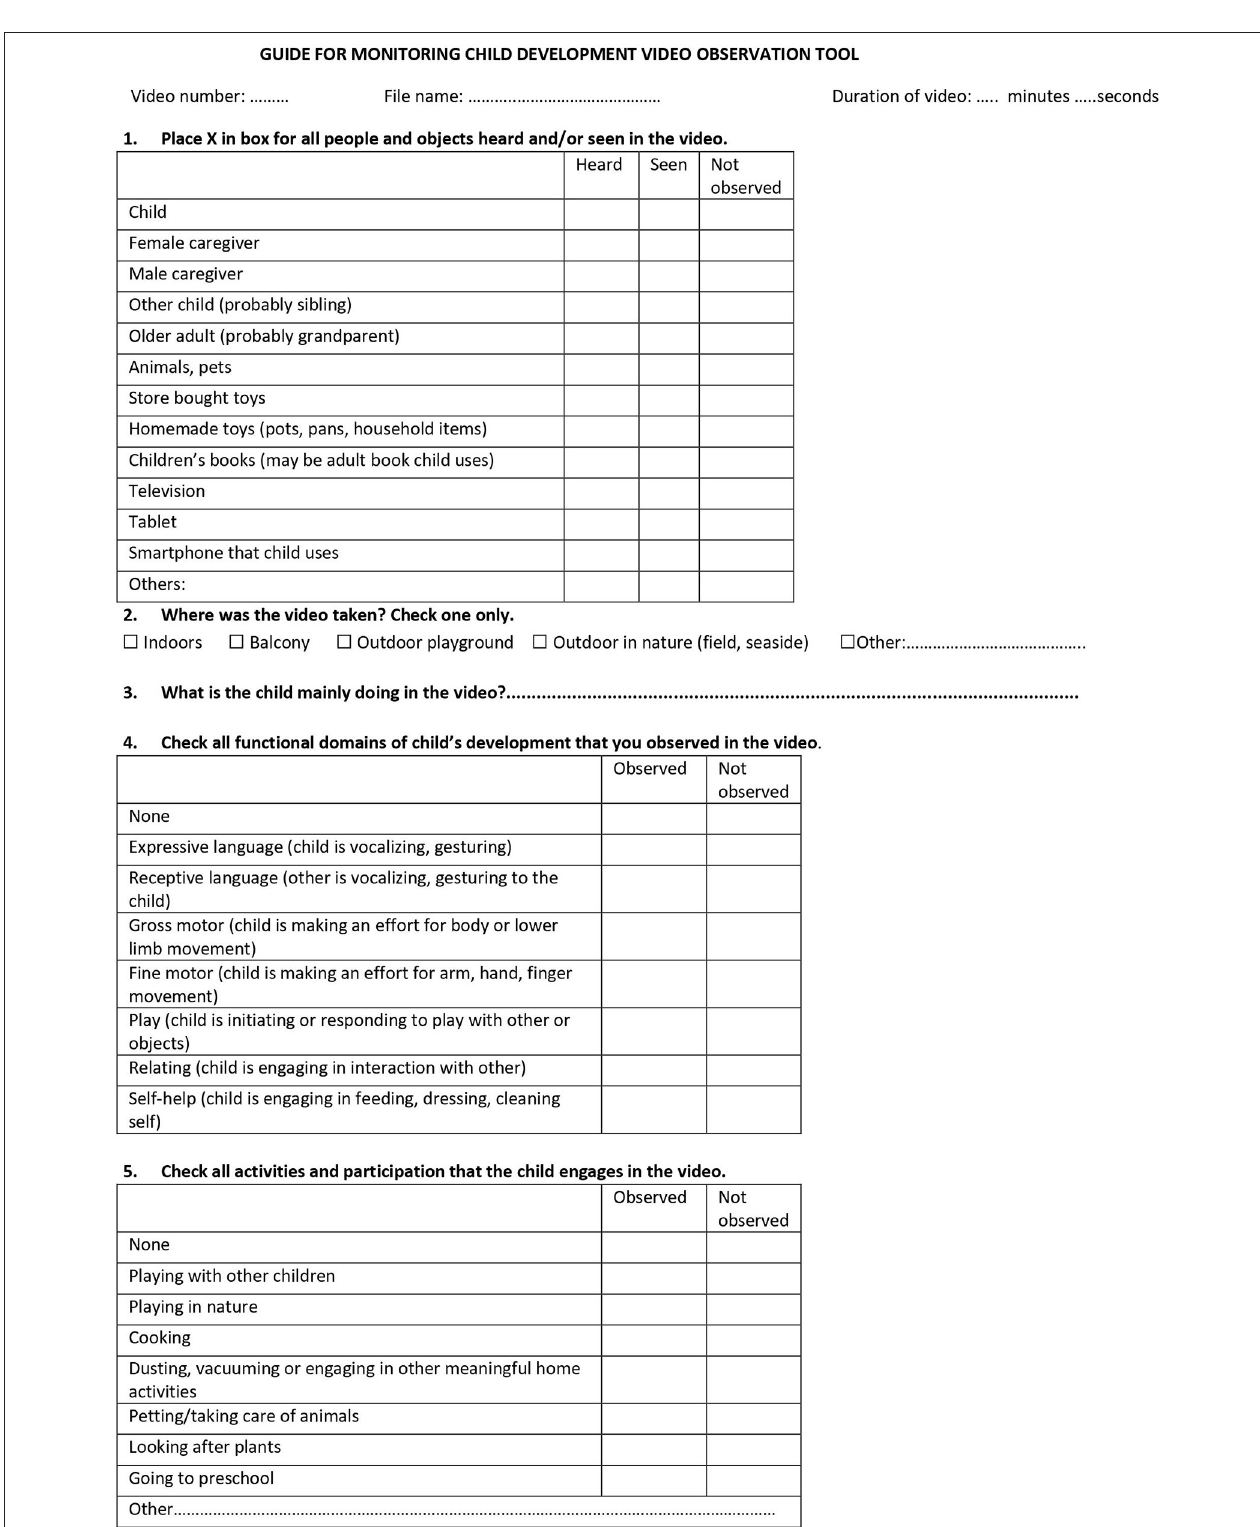
FIGURE 1 | Item examples of the Guide for Monitoring Child Development Video Observation Tool.